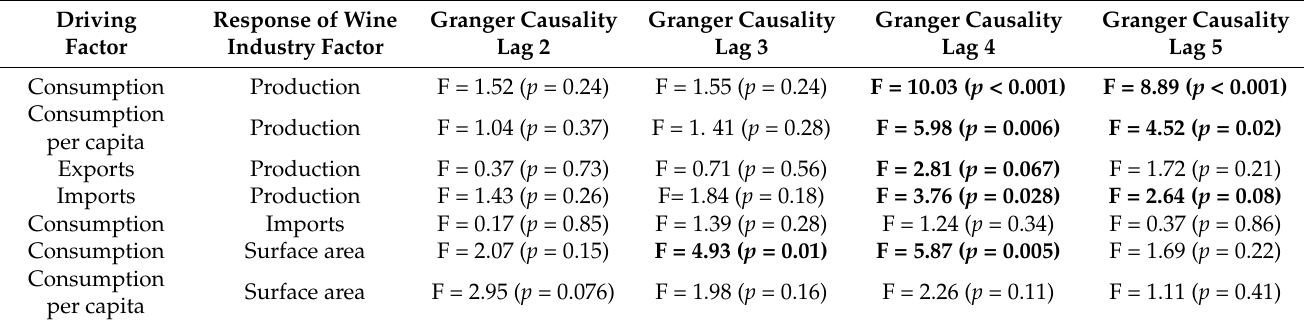
Table 1. Granger causality test results for bivariate global time series, with results for lags of 2–5. Results marked in bold denote significant relationship ( α = 0.05) among the factors (driving and response wine industry